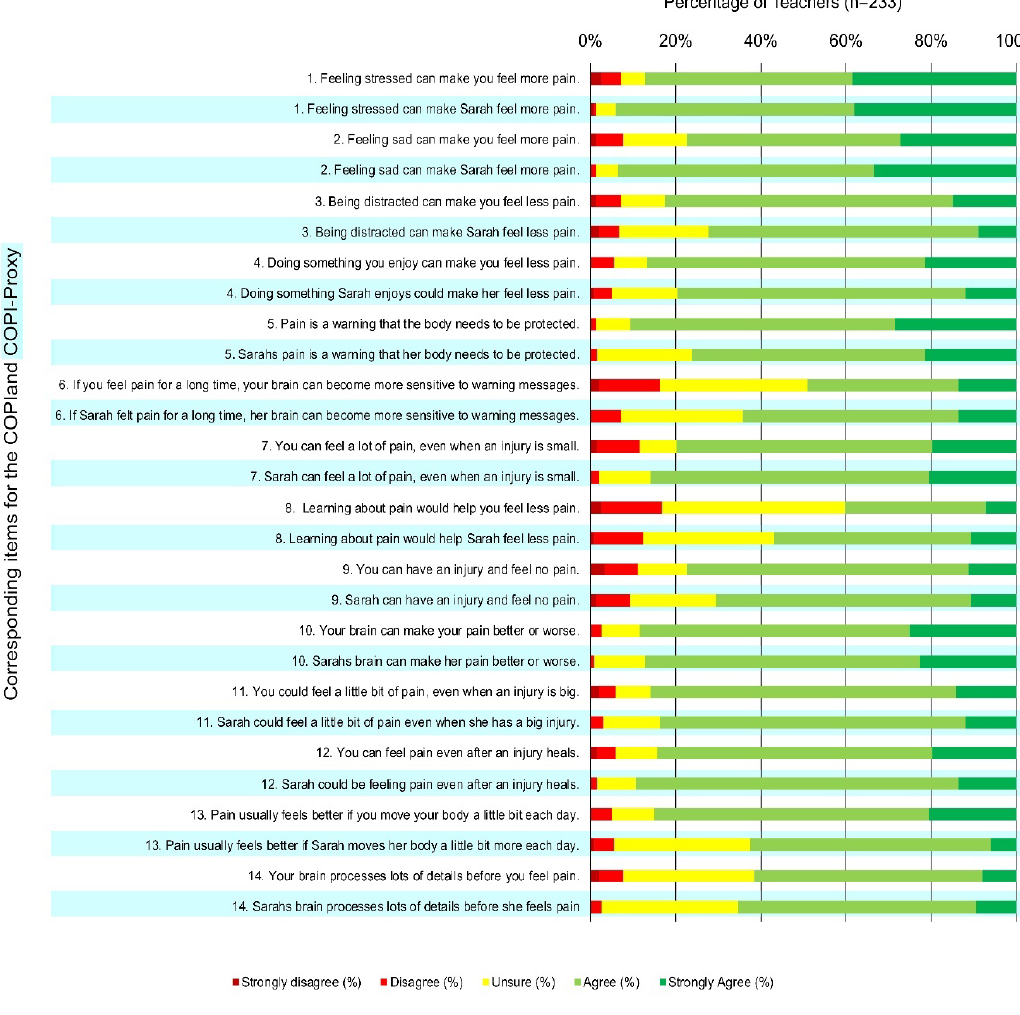
The visual inspection with scree plot elbow criteria (i.e., the point at which the down- ward curve levels off) suggested one factor similar to that of the COPI; however, three items in the COPI-Proxy did not load well onto this single factor (factor loading <0.32) [29]: Item 5: “Sarah’s pain is a warning that her body needs to be protected” (factor loading 0.14); Item 9: “Sarah can have an injury and feel no pain” (factor loading 0.18); and item 13: “Pain usually feels better if Sarah moves her body a little bit more each day” (factor loading 0.28). 3.3.2. Internal Consistency of the COPI-Proxy The internal consistency of the COPI-Proxy in this sample was acceptable (Cronbach’s alpha = 0.72).